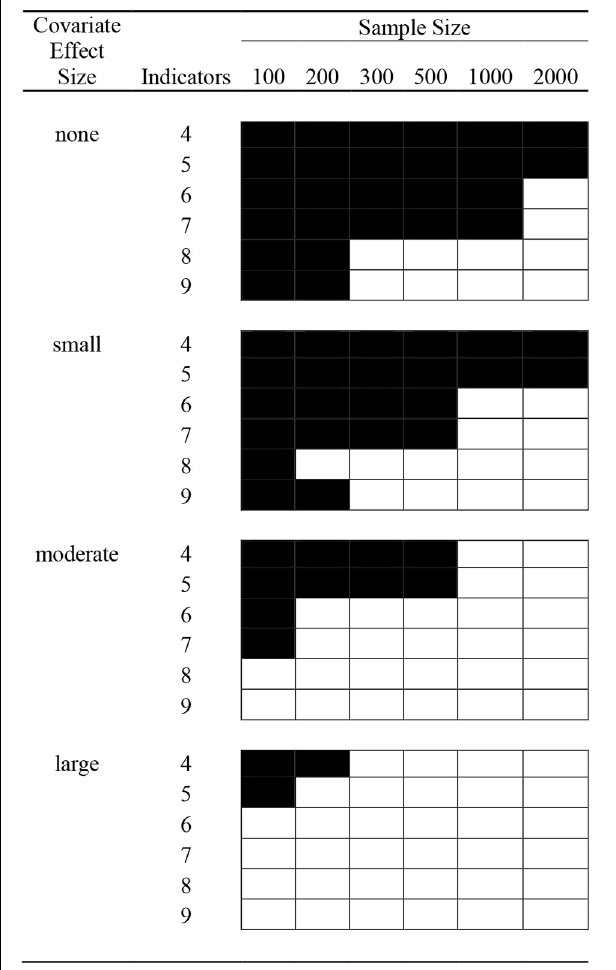
FIGURE 1 | 2-class, low indicator quality excluded conditions. Blackened cells indicate conditions where at least 50% of the replications were non-converged, label-switched, incorrigible, or had